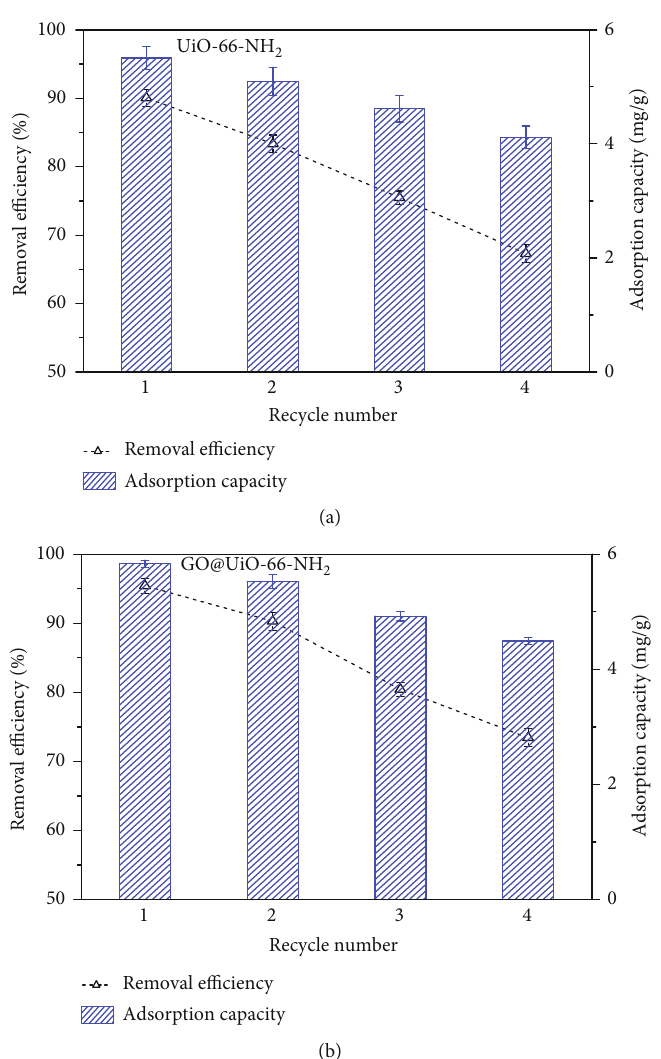
Figure 5: The desorption regeneration cycle e ff ect diagram of UiO-66-NH